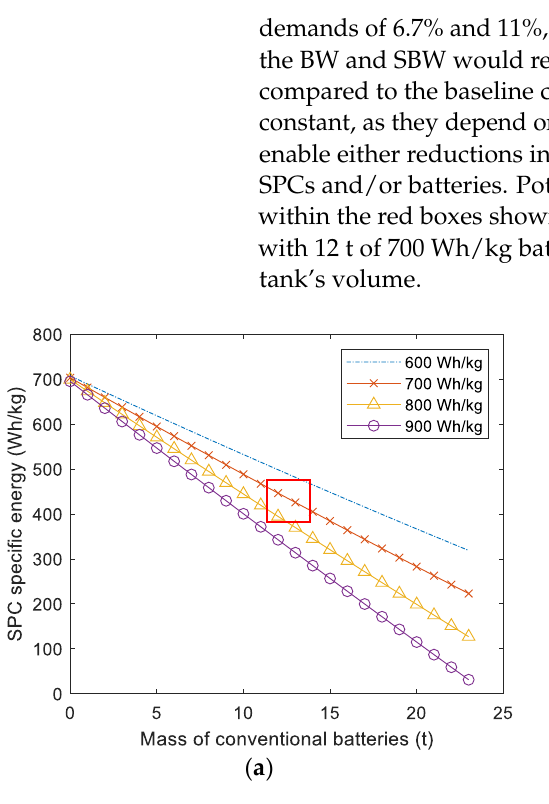
Figure 13. SPC E * requirements for AEA configurations over 1000 km with ( a ) box and ( b ) strut-braced wings for different battery pack-level E *. The red box highlights a zone which aims to simultaneously minimise the volume of batteries and the SPC E * requirements.